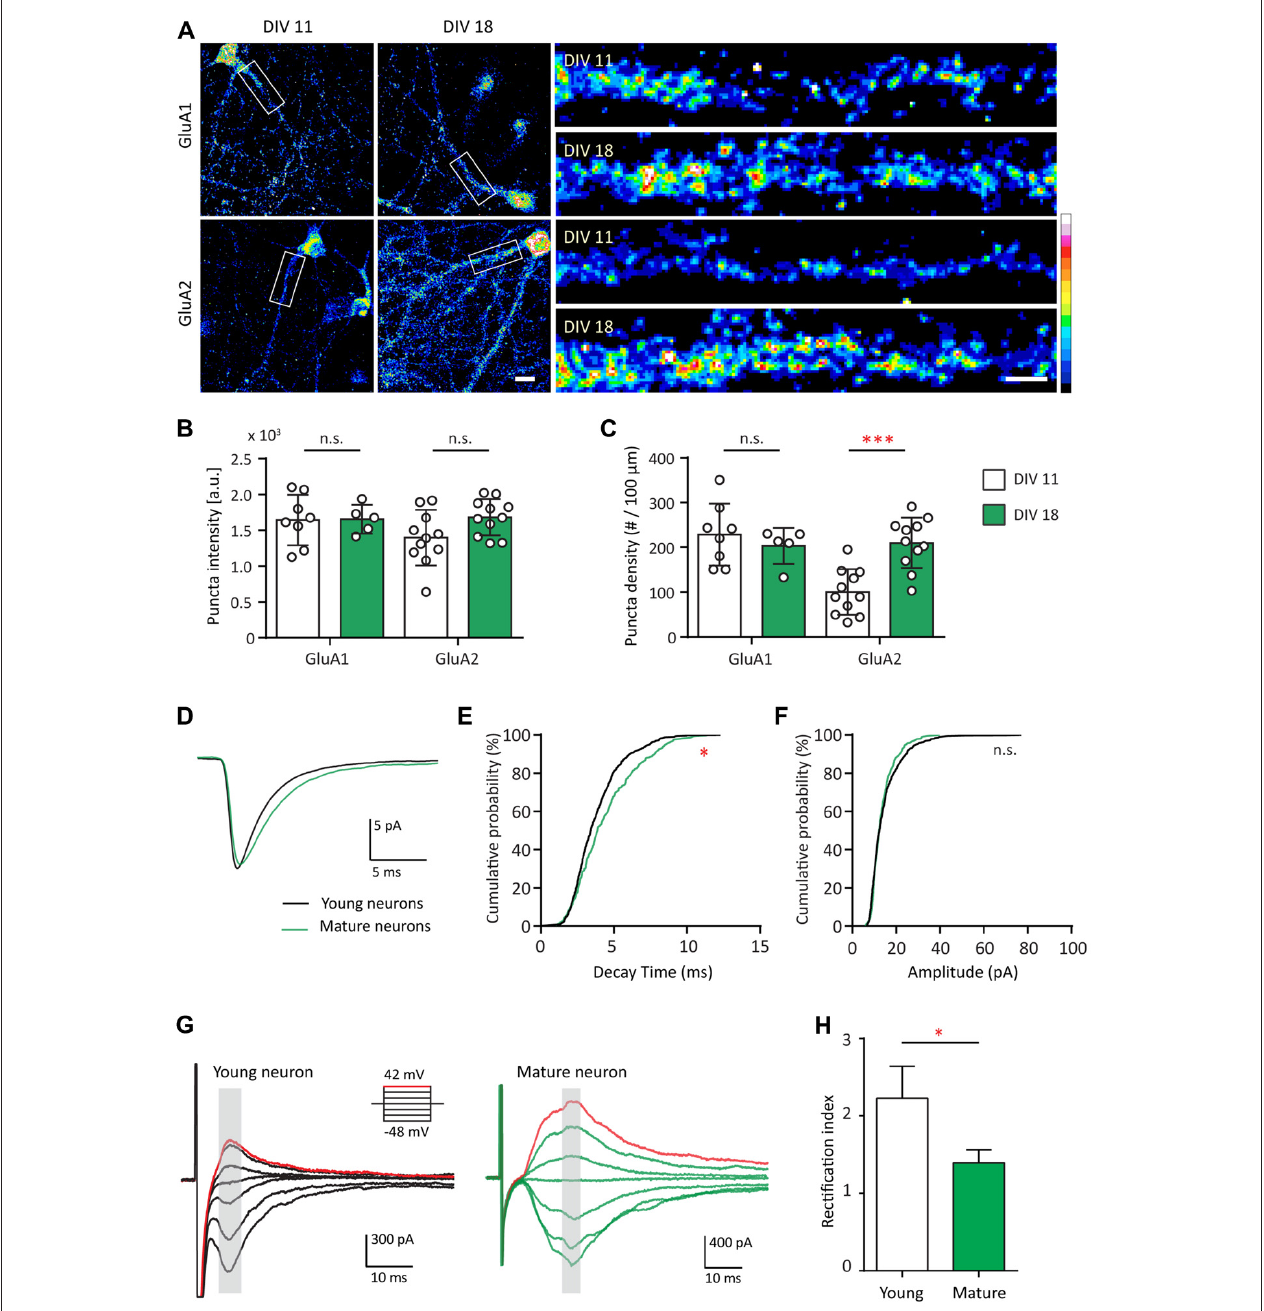
FIGURE 2 | AMPA receptor (AMPAR) subunit composition and functional change during development. (A) Hippocampal neurons were fixed and immunostained for GluA1 (top) or GluA2 (bottom) at DIV 11 and DIV 18. White boxes indicate the straightened dendrites (right). Scale bar: image, 15 µ m; dendrite, 5 µ m. (B,C) Summary graphs showing quantification of GluA1 and GluA2 puncta intensity (arbitrary fluorescent units—a.u.) (B) and density (puncta per 100 µ m; C ) [mean ± SEM; DIV 11, N = 8; DIV 18, N = 5 dendrites for GluA1; N = 11 for GluA2 from 5 to 10 neurons from two culture preps; Mann-Whitney test. n.s. p ≥ 0.05, ∗∗∗ p < 0.001]. (D) Ensemble-averaged miniature EPSCs (mEPSCs) from all events recorded in young (black) or mature (green) neurons [ N = 11 (young) and 10 (mature) neurons from 4 to 7 culture preps, which applies to all subsequent panels unless otherwise specified]. (E,F) Cumulative probability histograms of decay time (E) or amplitude (F) from all isolated events of young or mature neurons [Kolmogorov–Smirnov (K.S.) test, N = 600 events (young) and 400 events (for mature), n.s. p ≥ 0.005, ∗ p < 0.005]. (G) AMPAR-mediated EPSCs (averaged from three trials) evoked at various holding potentials (see diagram, upper right) from a young (black, left) or mature (green, right) hippocampal neuron. Red traces correspond to the current response at the most positive holding potential. Gray shaded bars used for calculating peak current amplitude. (H) Summary graph showing the difference of AMPAR inward rectification property between young and mature neurons [mean ± SEM; N = 29 cells (young) and 13 cells (mature) from 3 to 5 culture preps. Mann-Whitney test, ∗ p < 0.05].